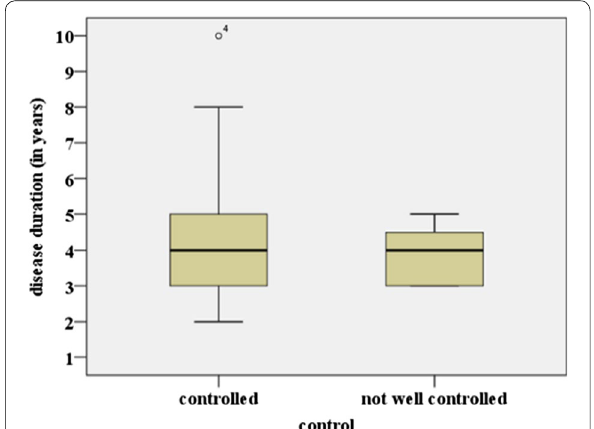
Fig. 3 Allergic rhinitis control: relation with disease